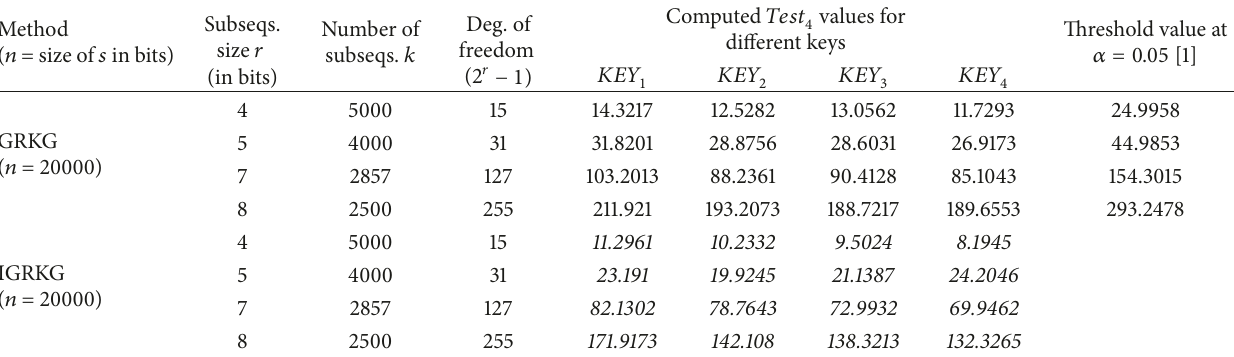
Table 10: 𝑇𝑒𝑠𝑡 1 values for a binary sequence 𝑠 of size 𝑛 = 20000 , where 𝑠 is generated individually from both the GRKG and the IGRKG generators corresponding to four different input 𝐾𝐸𝑌 parameters that have been mentioned in Table 6.